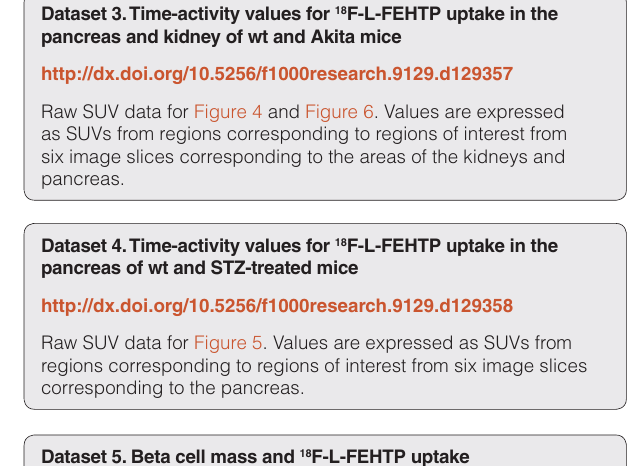
Raw SUV data for Figure 5. Values are expressed as SUVs from regions corresponding to regions of interest from six image slices corresponding to the